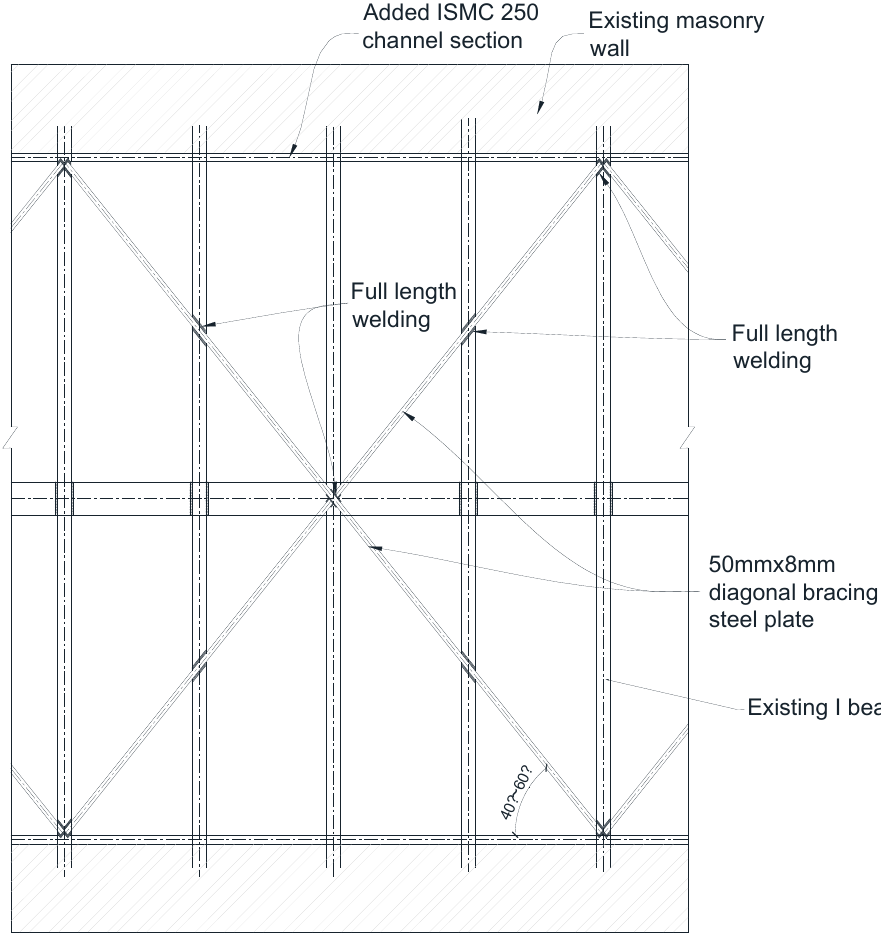
Figure 12. Details of bracing.